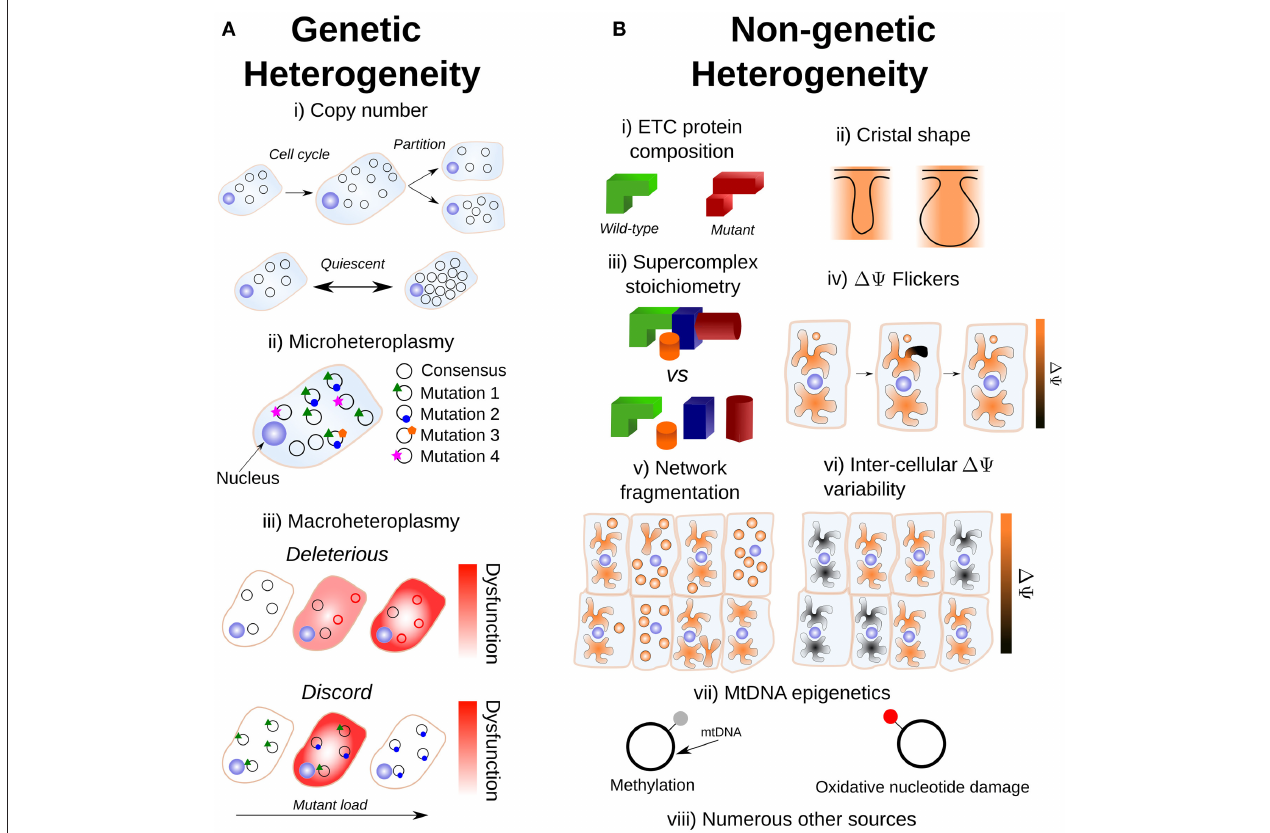
FIGURE 1 | Sources of mitochondrial heterogeneity from genetic and non-genetic mitochondrial sources. (A) Potential sources of mitochondrial genetic heterogeneity. (i) A proliferative cell which doubles in volume is expected to replicate its mtDNA complement by approximately × 2 to avoid dilution, which may confound measurements of copy number heterogeneity; noise at partitioning is thought to be somewhat suppressed. The extent of copy number heterogeneity in quiescent cells, and its consequences, are not fully understood. (ii) A cloud of mutations around the consensus sequence is expected given a finite mtDNA mutation rate; we term this “microheteroplasmy.” The actual mutant proportion for most mutations is expected to be very small in reality. (iii) In the more canonical case, “macroheteroplasmy,” a deleterious sequence (such as a deleterious single nucleotide polymorphism or deletion, red circles) induces a pathological phenotype above a threshold heteroplasmy. By contrast, intermediate heteroplasmy has been observed to induce large fitness disadvantages but homoplasmy does not, indicating discord between the two alleles. (B) Potential sources of mitochondrial non-genetic heterogeneity. (i) MtDNA sequence variation can induce variation in the structure of corresponding proteins. (ii) Cristal structure is variable and physiologically regulated to control respiratory output. (iii) A landscape of different supercomplex stoichiometries exists. (iv) Spatially-restricted, transient, depolarization/repolarization cycles of the mitochondrial network are observed. (v) The extent of mitochondrial fragmentation influences heteroplasmy dynamics (see Equation 1). (vi) Intercellular heterogeneity in mitochondrial membrane potential has been shown to be an important source of cellular noise. (vii) Potential sources of mitochondrial epigenetic heterogeneity. MtDNA is observed to undergo epigenetic modification by methylation, although the physiological significance of this is uncertain. Also, oxidative damage to mtDNA nucleotides may cause transcriptional errors. (viii) There are numerous other sources of non-genetic heterogeneity: from distinct spatial niches to ER-mitochondrial interactions. For further discussion, see Main